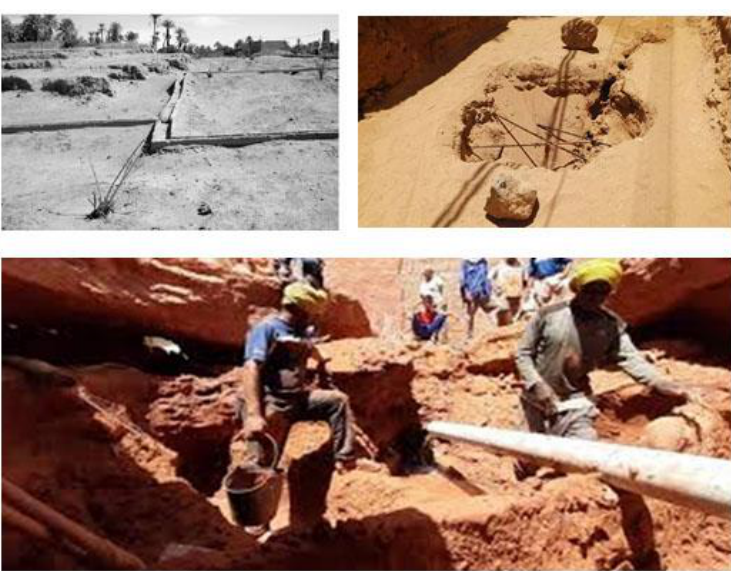
Figure 8 (Above) abandoned and collapsed foggara s(Remini et al., 2011) ; (Below), Collective work of maintenance for foggara in palm groves of Timimoun (Project Foggara Amghiar Timimoun)